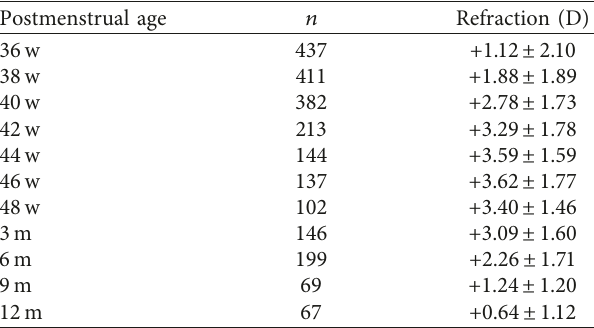
Table 1: SEs from 36weeks to one year of postmenstrual age.